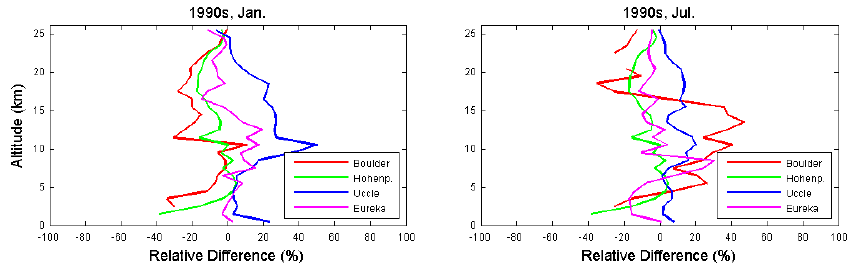
Fig. 2b. Same as Fig. 2a, but showing relative difference against ozonesondes at Boulder, Hohenpeissenberg (Hohenp. in the legend), Uccle, and Eureka in January (left) and July (right) in the